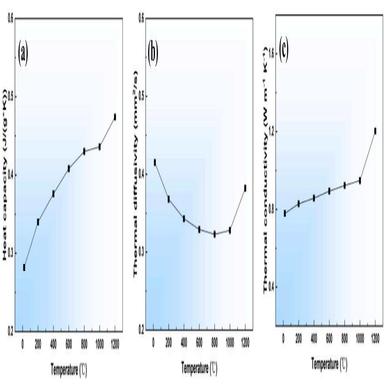
(a) Heat capacity, (b) Thermal diffusivity and (c) Thermal conductivity of Lu2SiO5 coatings.